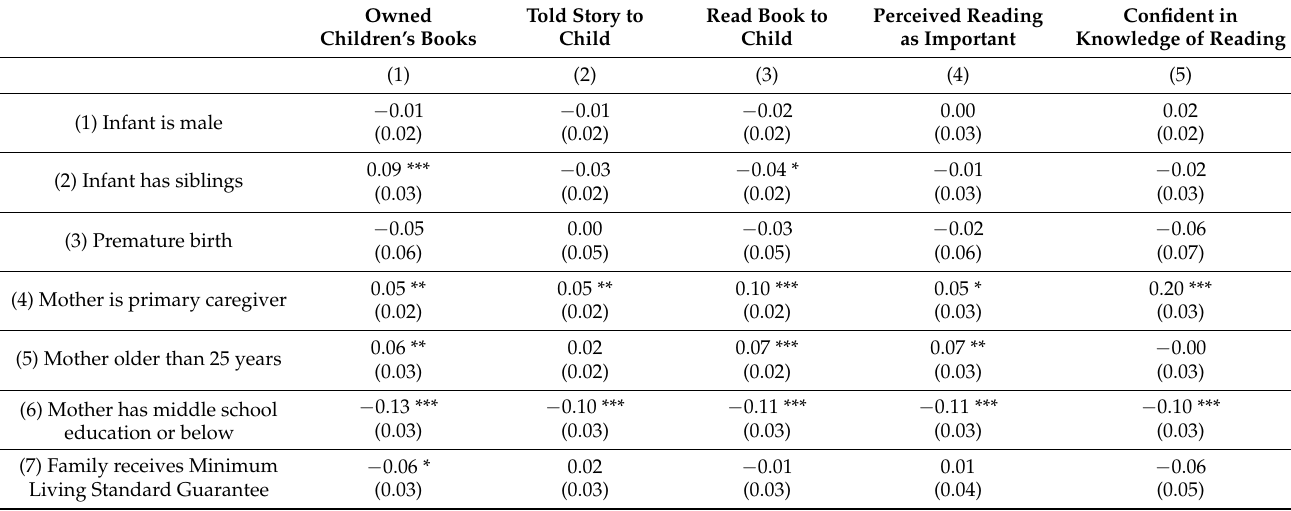
Table 4. Correlates of book ownership, reading behavior, perceived importance and knowledge of reading practices ( n =